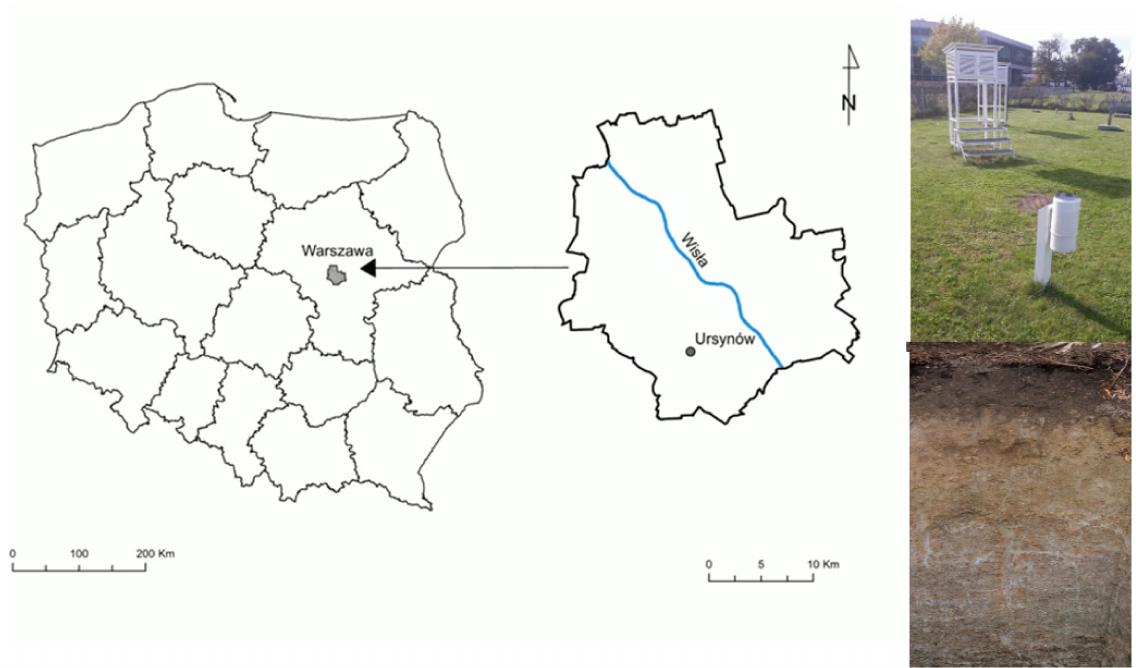
Figure 2. Location of the research